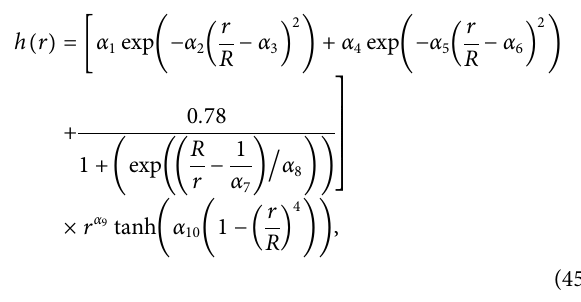
Frontiers in Astronomy and Space Sciences |